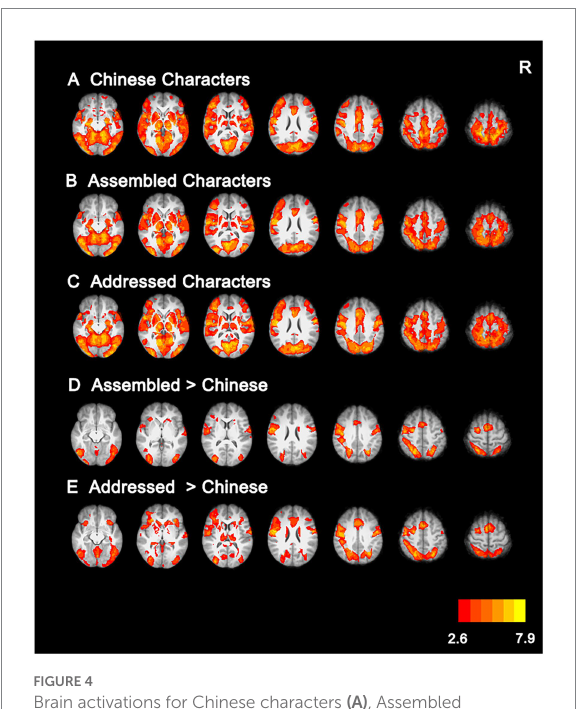
FIGURE 4 Brain activations for Chinese characters (A) , Assembled characters (B) , Addressed characters (C) , and their comparisons (D,E) . All activations were thresholded at p < 0.005 (whole-brain corrected). R,